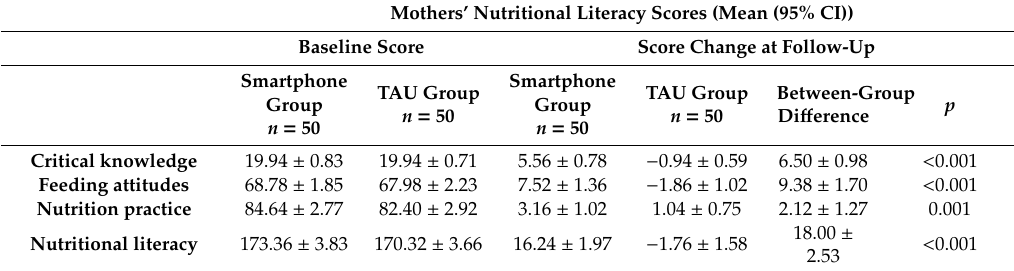
Table 3. Mothers’ nutritional literacy scores at baseline and score changes at follow-up in the smartphone and TAU groups (mean ( ± 95% Confidence Interval (95% CI)). P -values indicate di ff erence in score change between the study groups.